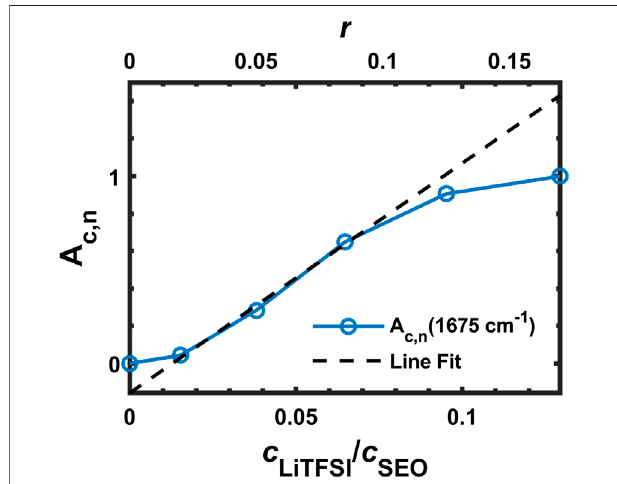
FIGURE 9 | A c , n of the FTIR band at 1,675 cm − 1 with line fi tting.